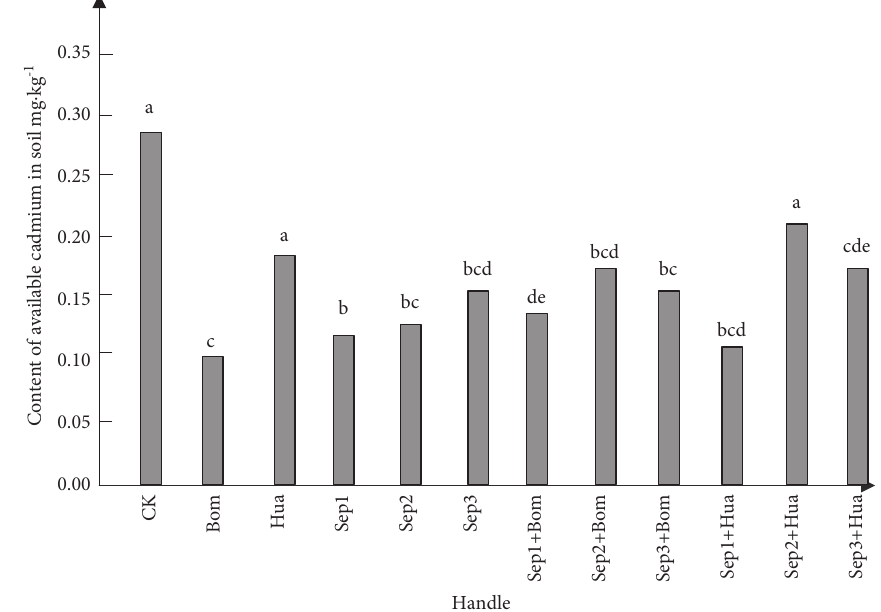
Figure 2: Effect of passivation treatment on the content of available cadmium in